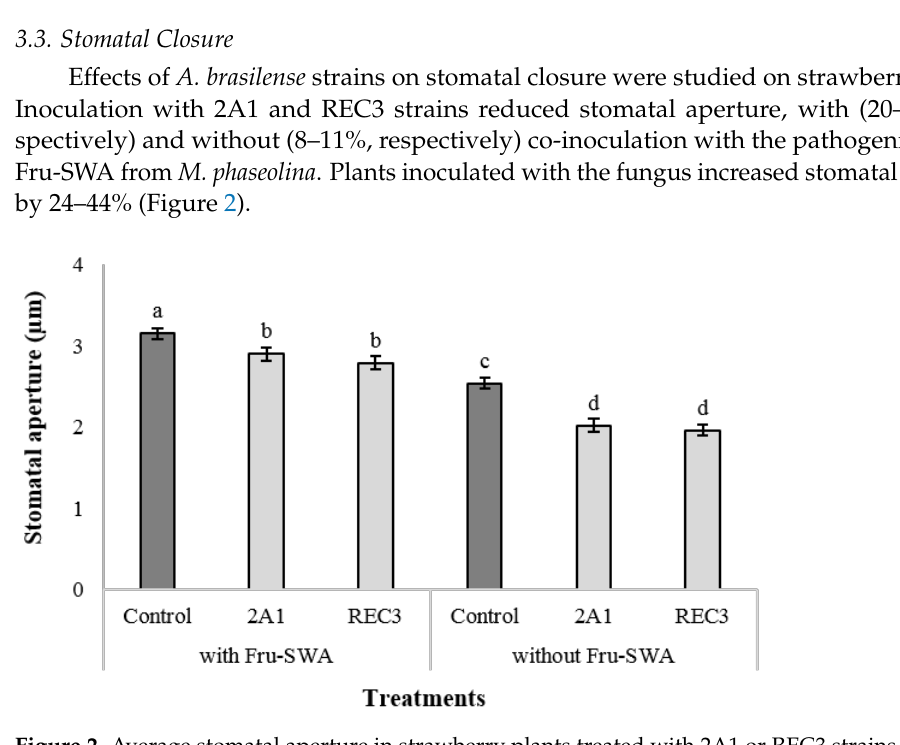
Figure 2. Average stomatal aperture in strawberry plants treated with 2A1 or REC3 strains, with and without the inoculation with the M. phaseolina Fru-SWA isolate, and control plants (with and without Fru-SWA). Error bars represent the standard error. Different letters denote significant differences ( P ≤ 0.05) .